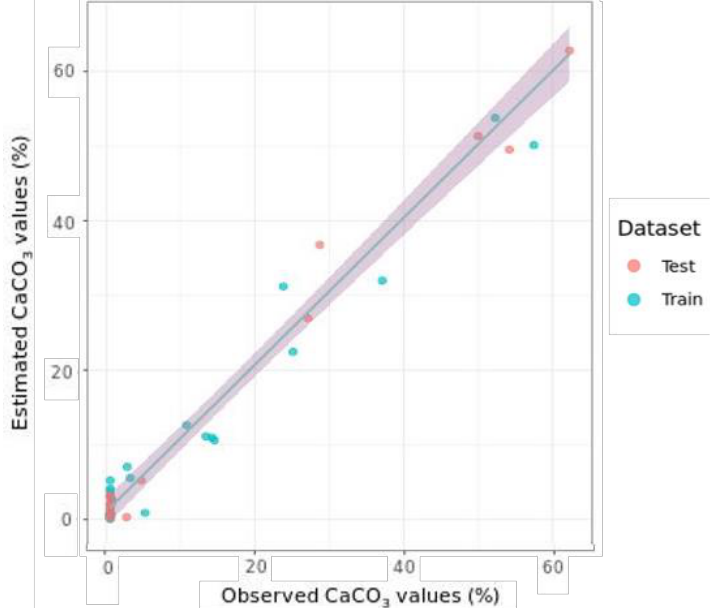
Figure 14. Scatter plot of the best fitted model (PLSR, Absorbance, Savitzky–Golay 2nd derivative, and SNV normalization) for the CaCO 3 predictions using the laboratory (PSR+ 3500) data, including the regression line (blue) with the 95% confidence interval (grey).